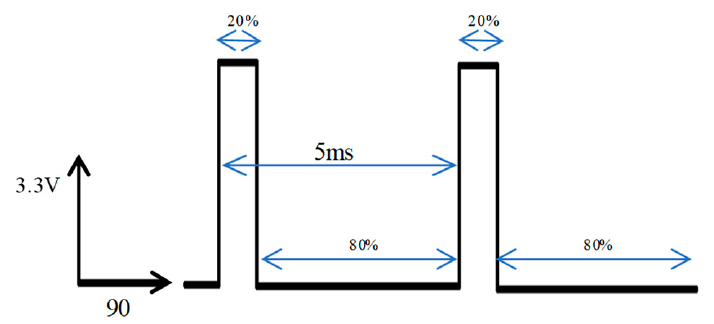
Figure 6. The stimulation signal of positive potential pulses sequence.